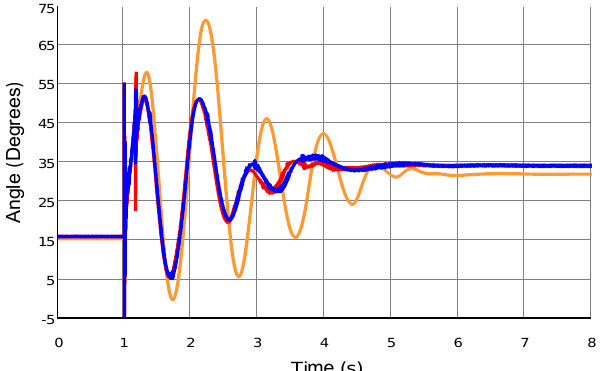
Figure 15. Machine A angle response against a 10-cycle fault: no SVC (yellow), proposed RTDS-based WAC-SVC (red), and delay-compensated HIL-based WAC-SVC (blue).